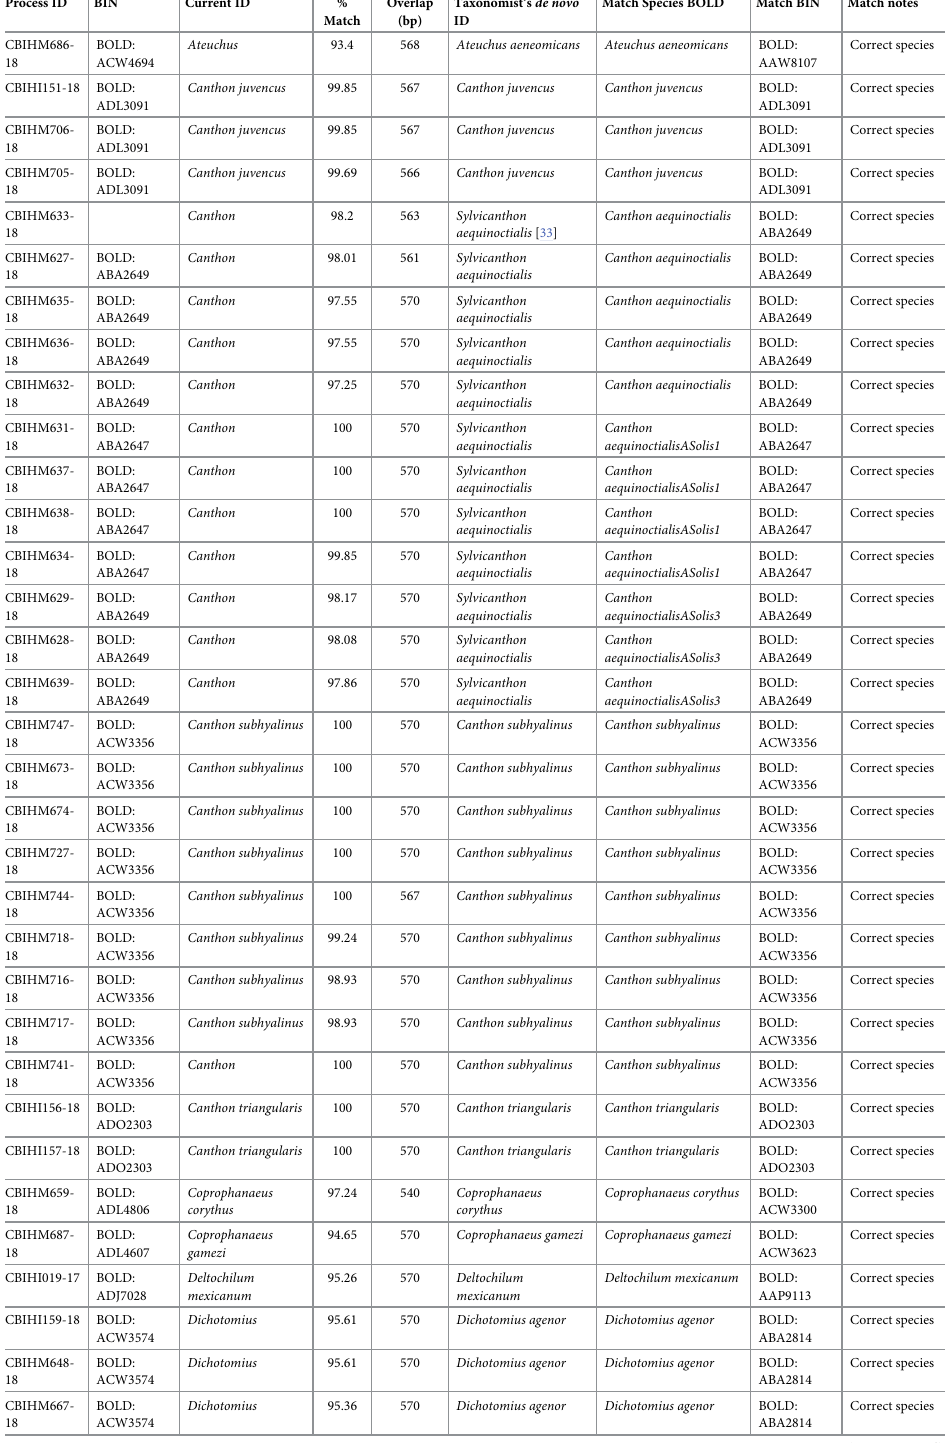
Table 4. List of Scarabaeinae species identified by BOLD in agreement with the taxonomist’s de novo identifica- tion. Morphospecies with genus and code "H" are included [27]. Only categories for correct species and probably cor- rect species are presented